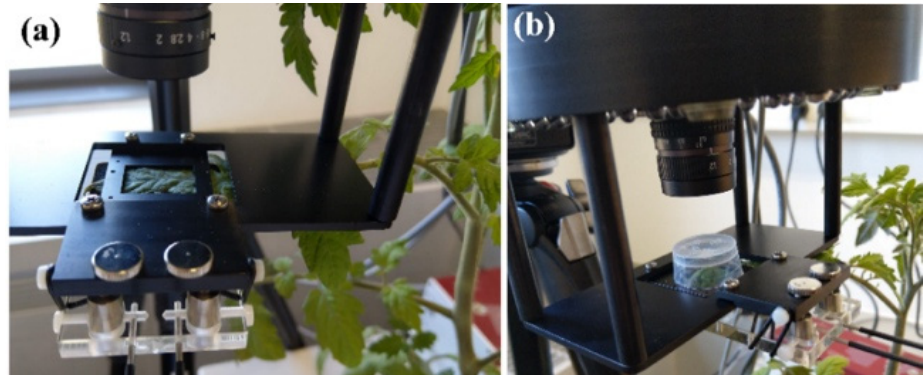
Figure 1. The layout of the experimental setup for chlorophyll fluorescence measurements. The terminal leaflet of the 6th leaf is placed in the instrument for the measurement before feeding ( a ), and then the larva was added on top of the leaflet ( b ). A protective cap (with holes on the top for ventilation) was placed to restrain the movement of the larva for the 15 min of feeding.